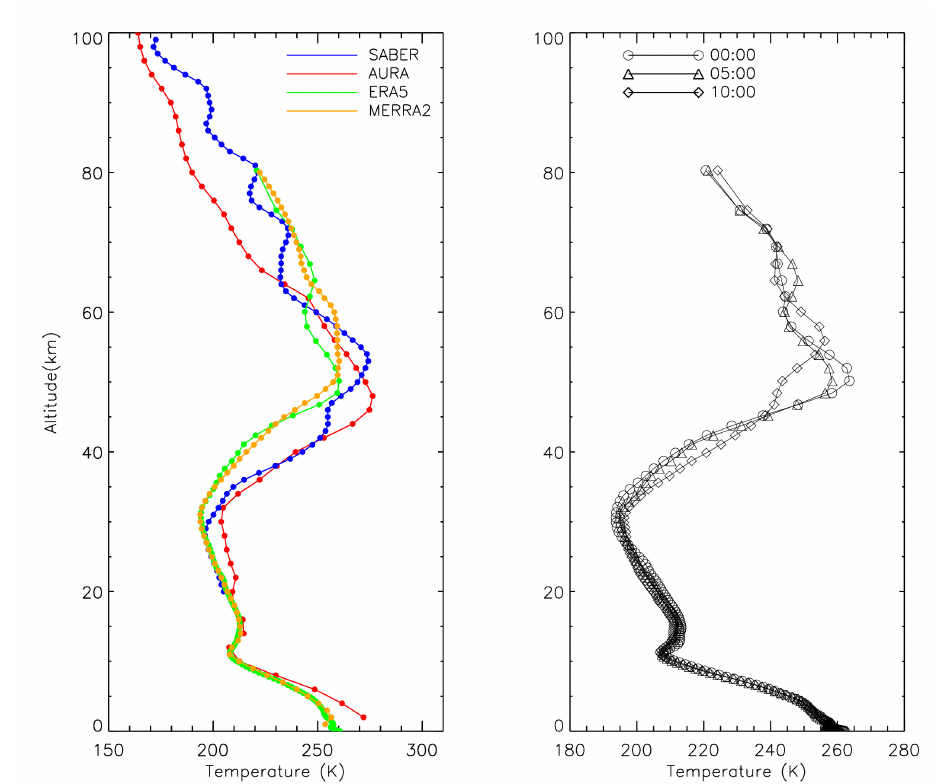
Figure 12. At left, vertical temperatures profiles obtained by ERA-5 reanalysis (green) and MERRA-2 reanalysis (orange) at July 21 4:00 UT, and profiles measured by TIMED/SABER (blue) at 02:14 UT, and AURA/MLS (red) at 04:38 UT. At right, three temperatures profiles of ERA-5 reanalysis at 00:00, 06:00, 10:00 UT of July 21. Table 2. Wave path results obtained by the reverse ray tracing model to each wave listed in Table 1. Wave